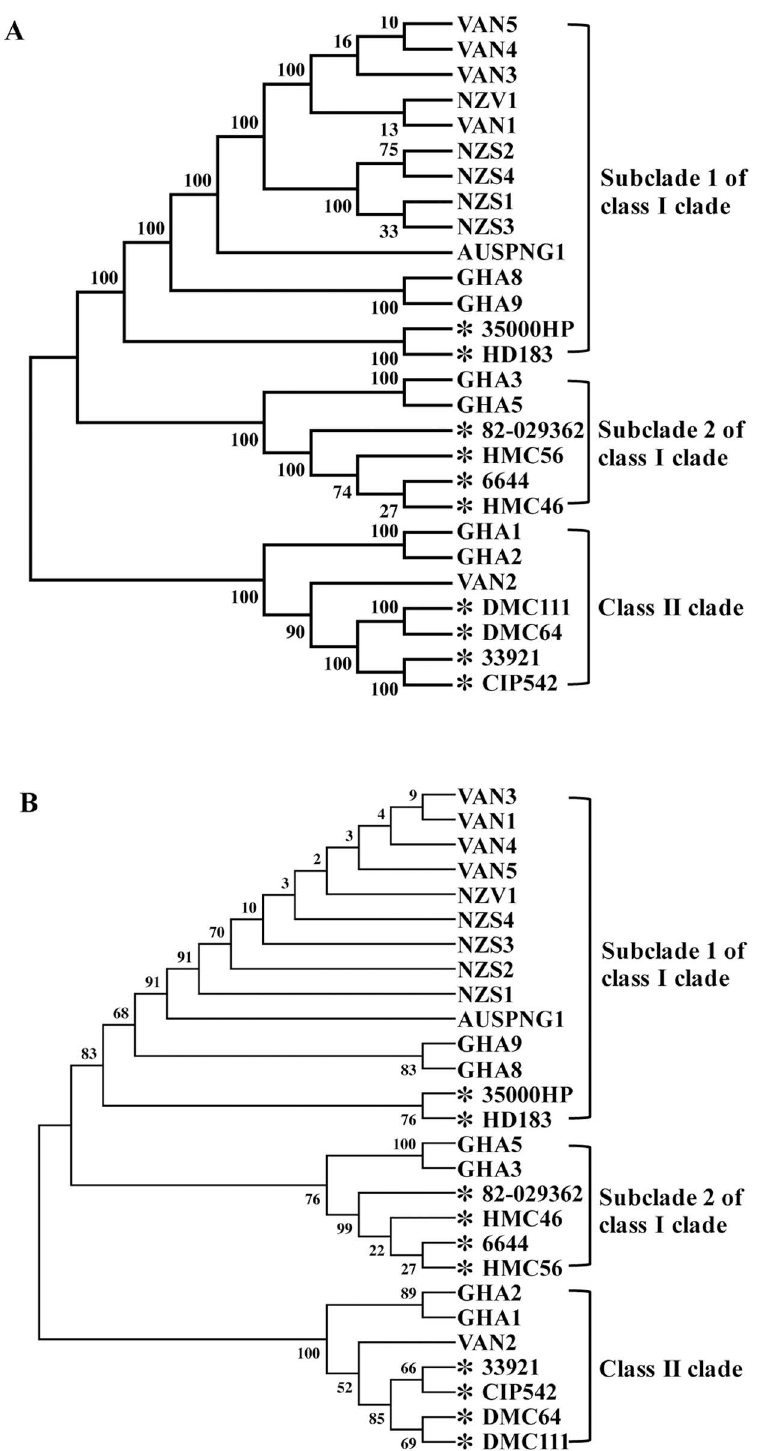
Fig 1. The evolutionary relationship of the uncharacterized CU strains to previously-characterized CU and GU strains. A . Phylogenetictree of H . ducreyi CU and GU strains basedon whole-genome sequences. B . Phylogenetic tree of H . ducreyi CU and GU strains based on dsrA - hgbA - ncaA sequences. The evolutionary relationshipwas inferred by using the Maximum Likelihoodmethod basedon the Hasegawa- Kishino-Yano model. The reliabilityof the tree was tested using 500 bootstrapreplicates;the